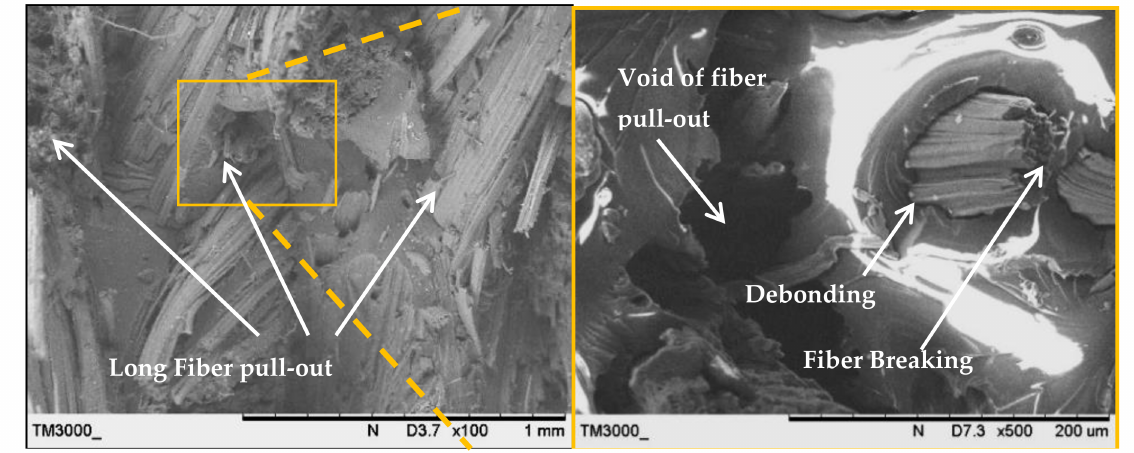
Figure 9. Scanning electron microscopy images of the untreated PALF laminate (PPPP-untreated) with ply orientation [ ± 45 ◦ ] n at 100 and 500